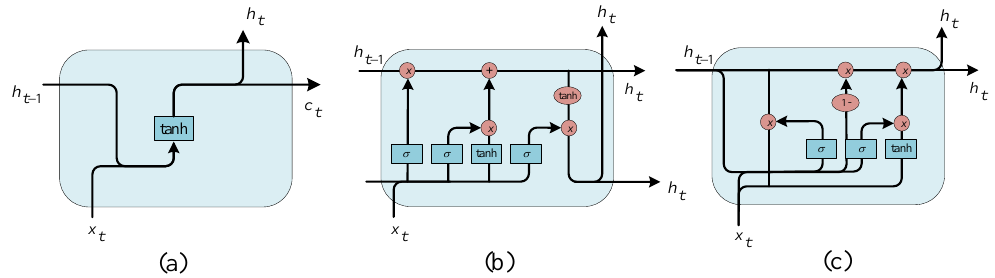
Figure 7. Internal structures of the conventional RNN, LSTM, and GRU. ( a ) Conventional RNN, ( b ) LSTM, ( c ) GRU.